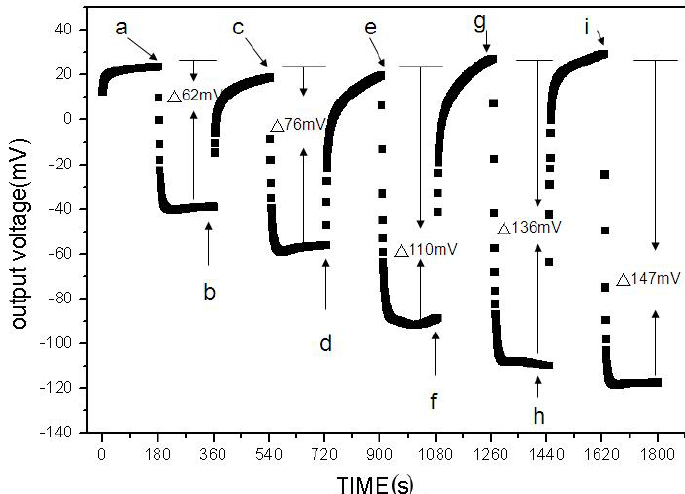
Figure 6. Measurement result of urea concentration.